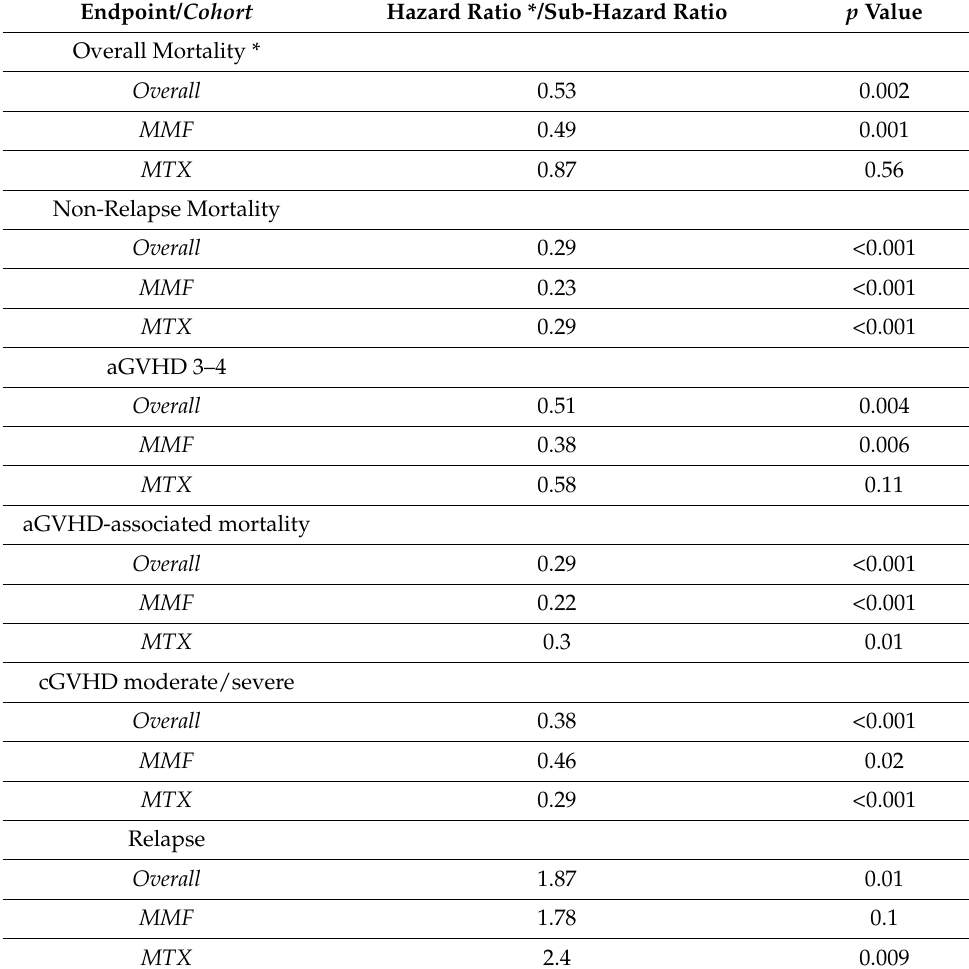
Table 2. Multivariable analyses for the adjusted effect of ATLG on various endpoints in the overall cohort (n = 401), as well as in the MMF (n = 193) and the MTX (n = 208) subgroup, respectively. For overall mortality, the Cox proportional hazards model was used, and for the other endpoints, the Fine and Grey regression was used, considering competing risks. Endpoint/ Cohort Hazard Ratio */Sub-Hazard Ratio p Value Overall Mortality * Overall 0.53 0.002 MMF 0.49 0.001 MTX 0.87 0.56 Non-Relapse Mortality Overall 0.29 <0.001 MMF 0.23 <0.001 MTX 0.29 <0.001 aGVHD 3–4 Overall 0.51 0.004 MMF 0.38 0.006 MTX 0.58 0.11 aGVHD-associated mortality Overall 0.29 <0.001 MMF 0.22 <0.001 MTX 0.3 0.01 Overall 0.38